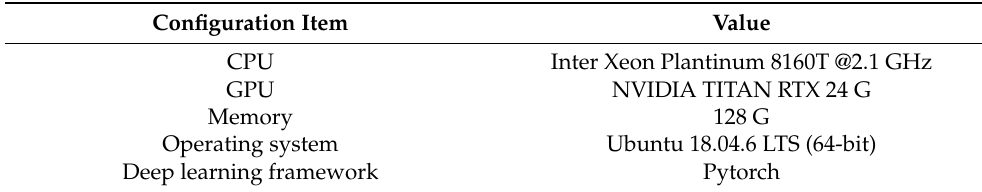
Table 3. Hardware and software environments.